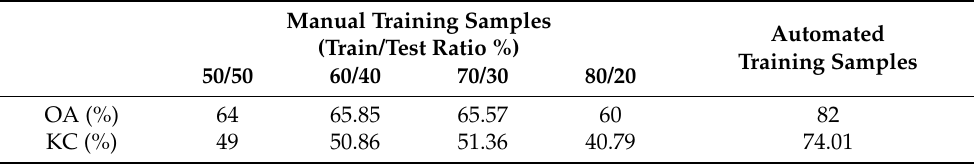
Table 9. Comparison of automated training samples with manual